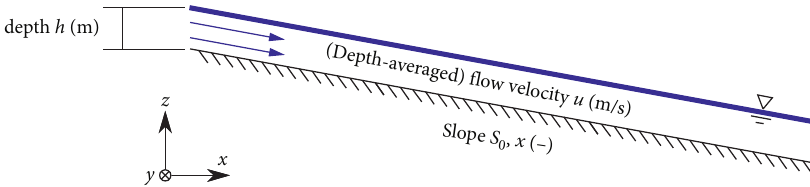
Figure 4: Model of water flow with velocity u over a pavement surface in the x -direction. The flow velocity v in the y -direction can be modeled